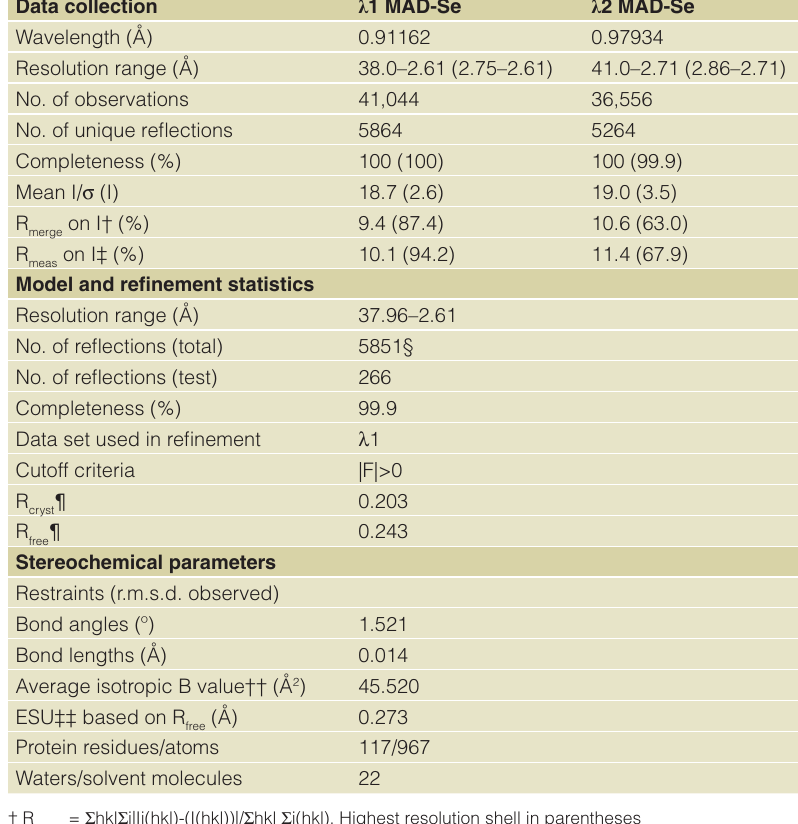
Supplementary table 1. Crystallographic data and refinement statistics for IPI, BSU11130 (PDB code 3ISY). Values in parentheses are for the highest resolution shell.